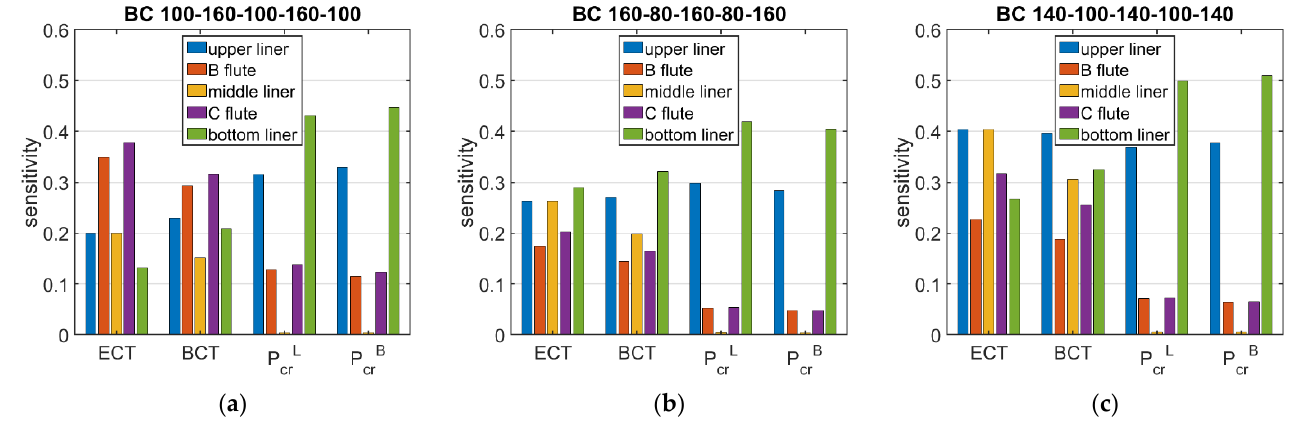
Figure 6. Average sensitivity of ECT, P cr , and BCT of all boxes in relation to the layer grammage perturbation for BC cardboard of selected grades: ( a ) 100-160-100-160-100, ( b ) 160-80-160-80-160, and ( c ) 140-100-140-100-140.